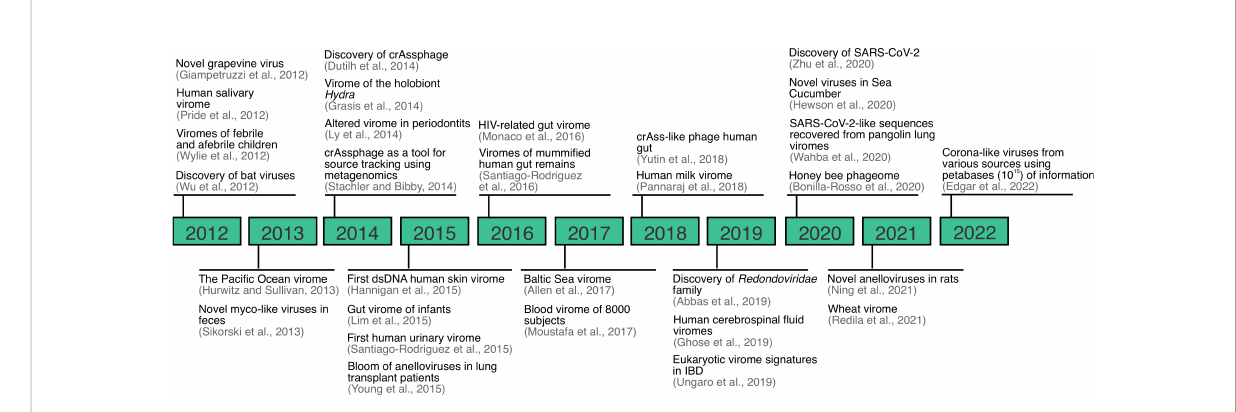
FIGURE 2 Overview of important viral metagenomic or virome studies landmarks between 2012-2022. Expanded from